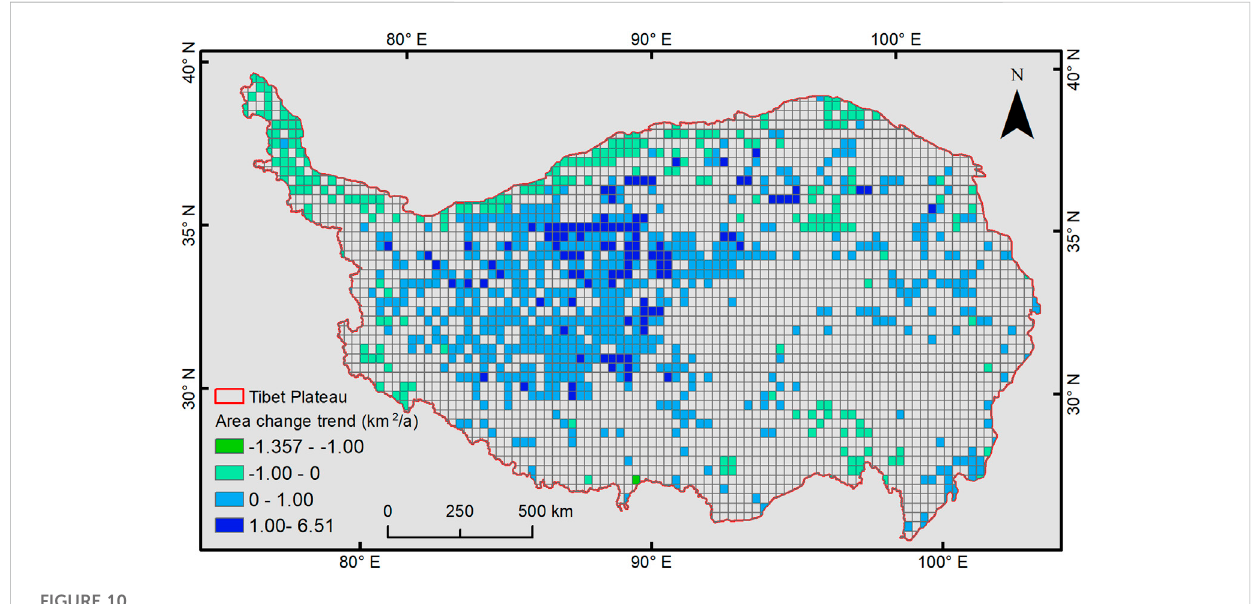
FIGURE 10 The region of signi fi cant change in surface water area (1990 –